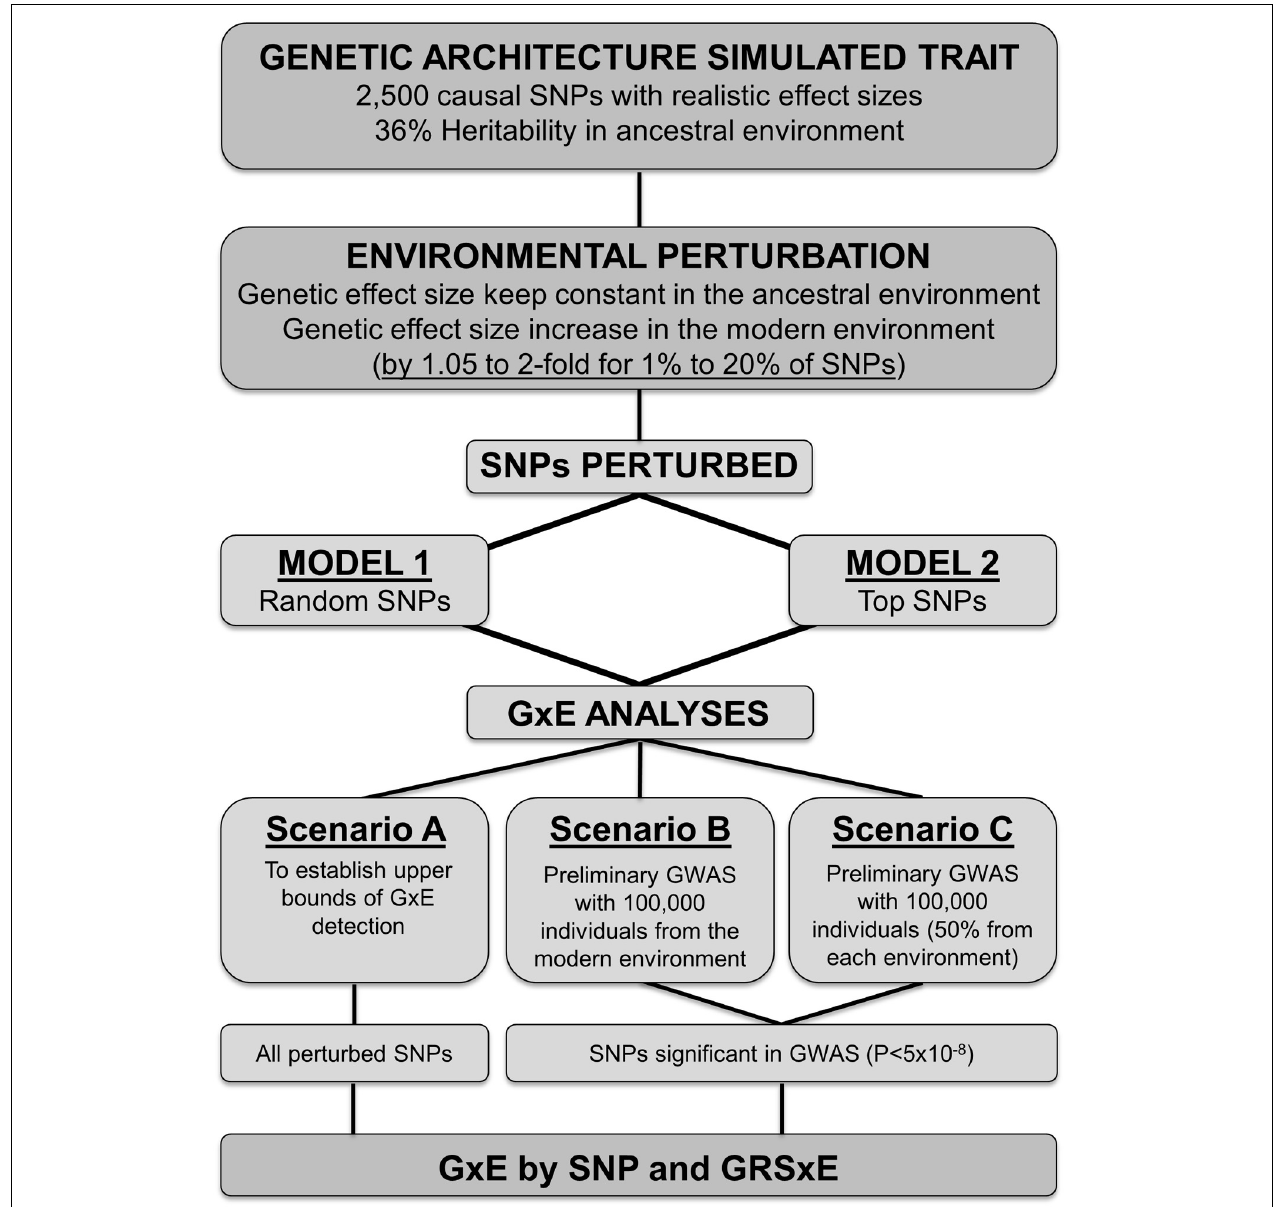
FIGURE 1 | Summary of the steps followed in the